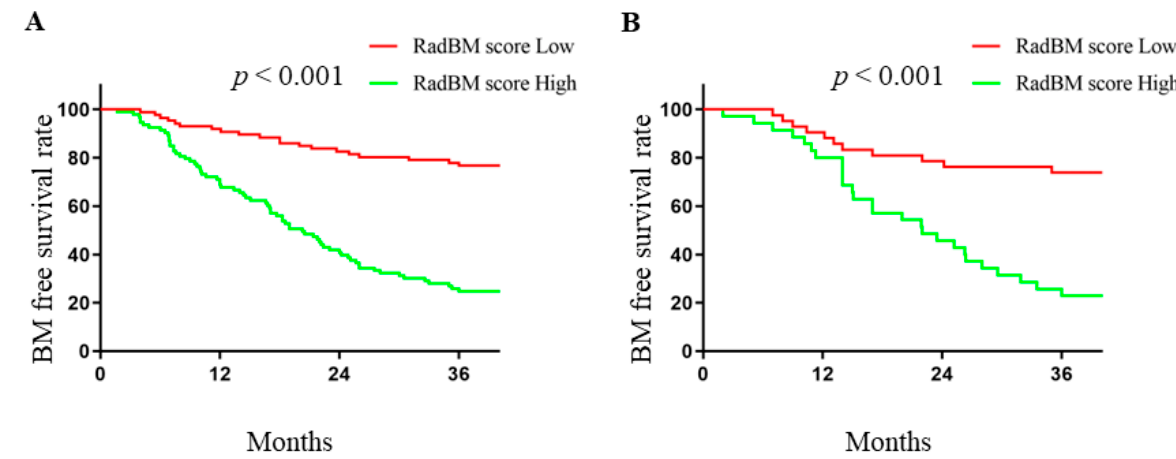
Figure 3. Kaplan–Meier curves of brain metastasis‑free survival according to RadBM score in the training ( A ) and testing ( B ) datasets. Comparison between groups were calculated using Log‑rank test. Table 3. Distribution of Brain Metastasis in NSCLC patients. Within HA Rest of The Brain within 5 mm of HC 5–15 mm from HC >15 mm from HC No. of lesions (565 in 128 patients) 7 23 535